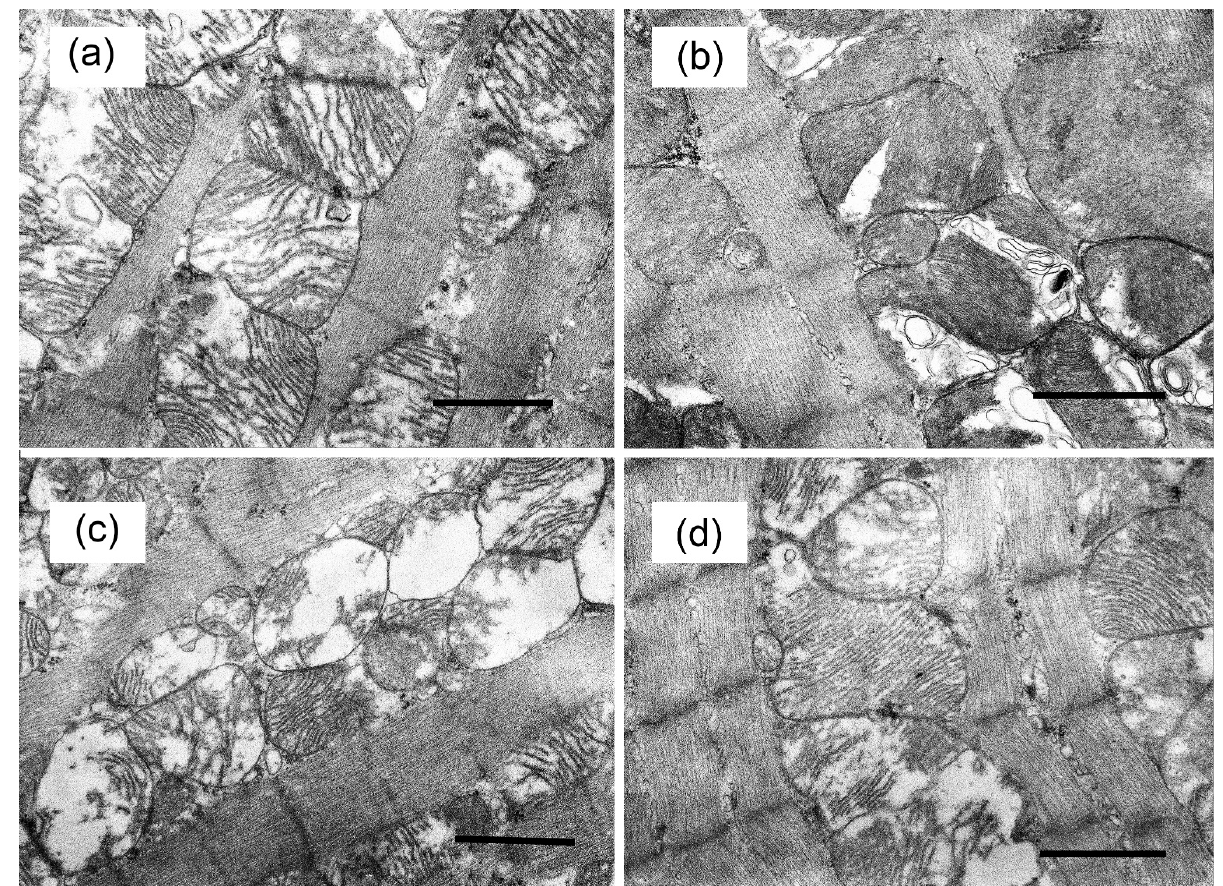
Figure 5. Typical electron micrographs of mouse heart mitochondria in the experimental groups: CTR ( a ), CTR + Ali ( b ), DM ( c ), and DM + Ali ( d ). The bar is equal to 1 μ m.